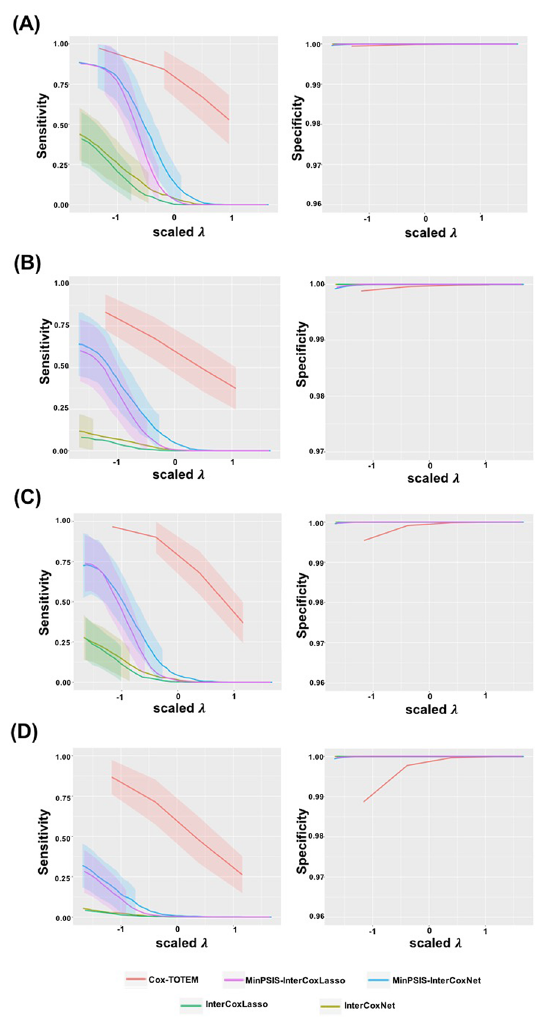
Figure 2. Plot of mean sensitivity (left) and mean specificity (right) against the scaled (cid:31) values for ( A ) Homo-S; ( B ) Homo-W; ( C ) Hetero-S; ( D ) Hetero-W scenarios with n = 100 and p = 2000 . Shades denote the standard deviations. The original (cid:31) values are rescaled in all methods for fair comparison.